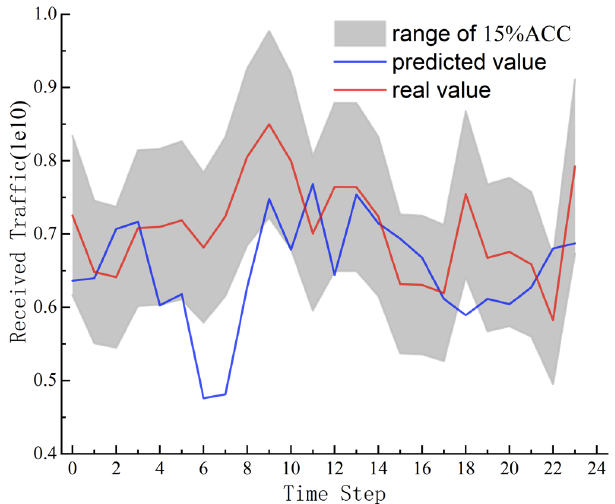
Figure 9. MLP model prediction results.